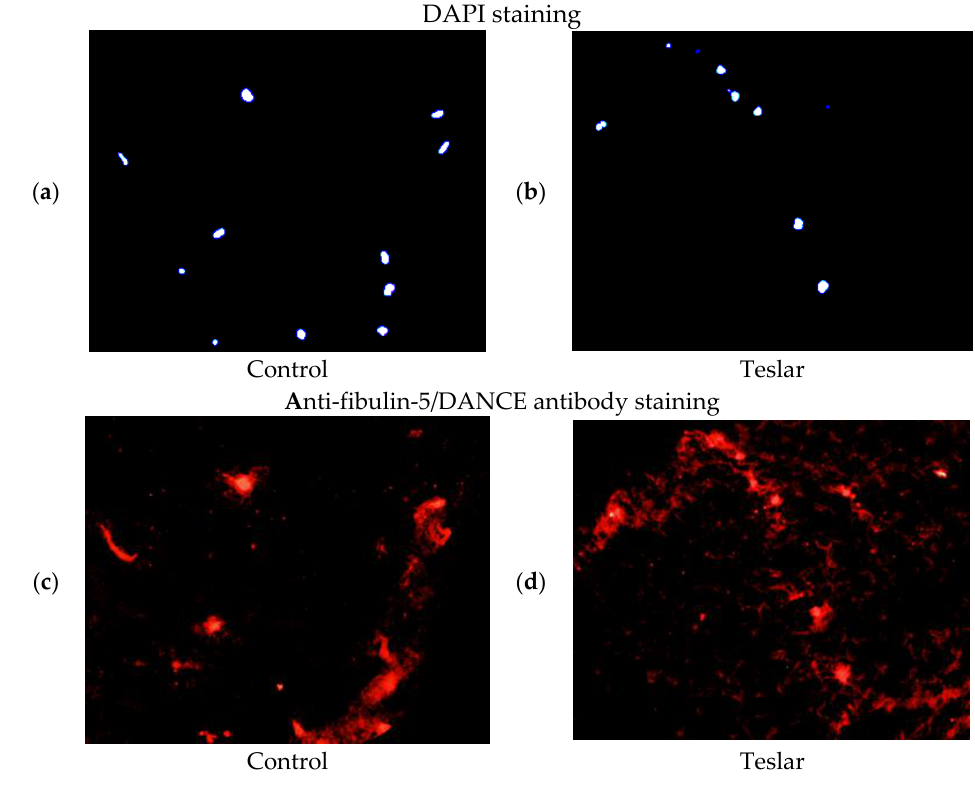
Figure 6. Teslar effect on fibulin-5/DANCE protein in collagen gel-cultured human fibroblasts. ( upper ) DAPI staining of ( a ) control and ( b ) Teslar treatment collagen gel-cultured human fibroblasts, and ( bottom ) anti-fibulin-5/DANCE antibody staining of ( c ) control and ( d ) Teslar treatment collagen gel-cultured human fibroblasts.